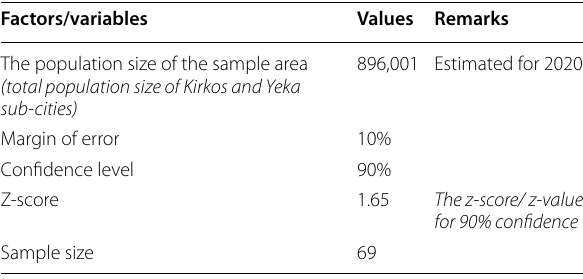
Stratified random sampling was implemented to identify the sample size for the questionnaire with a 10% margin of error and 90% confidence level